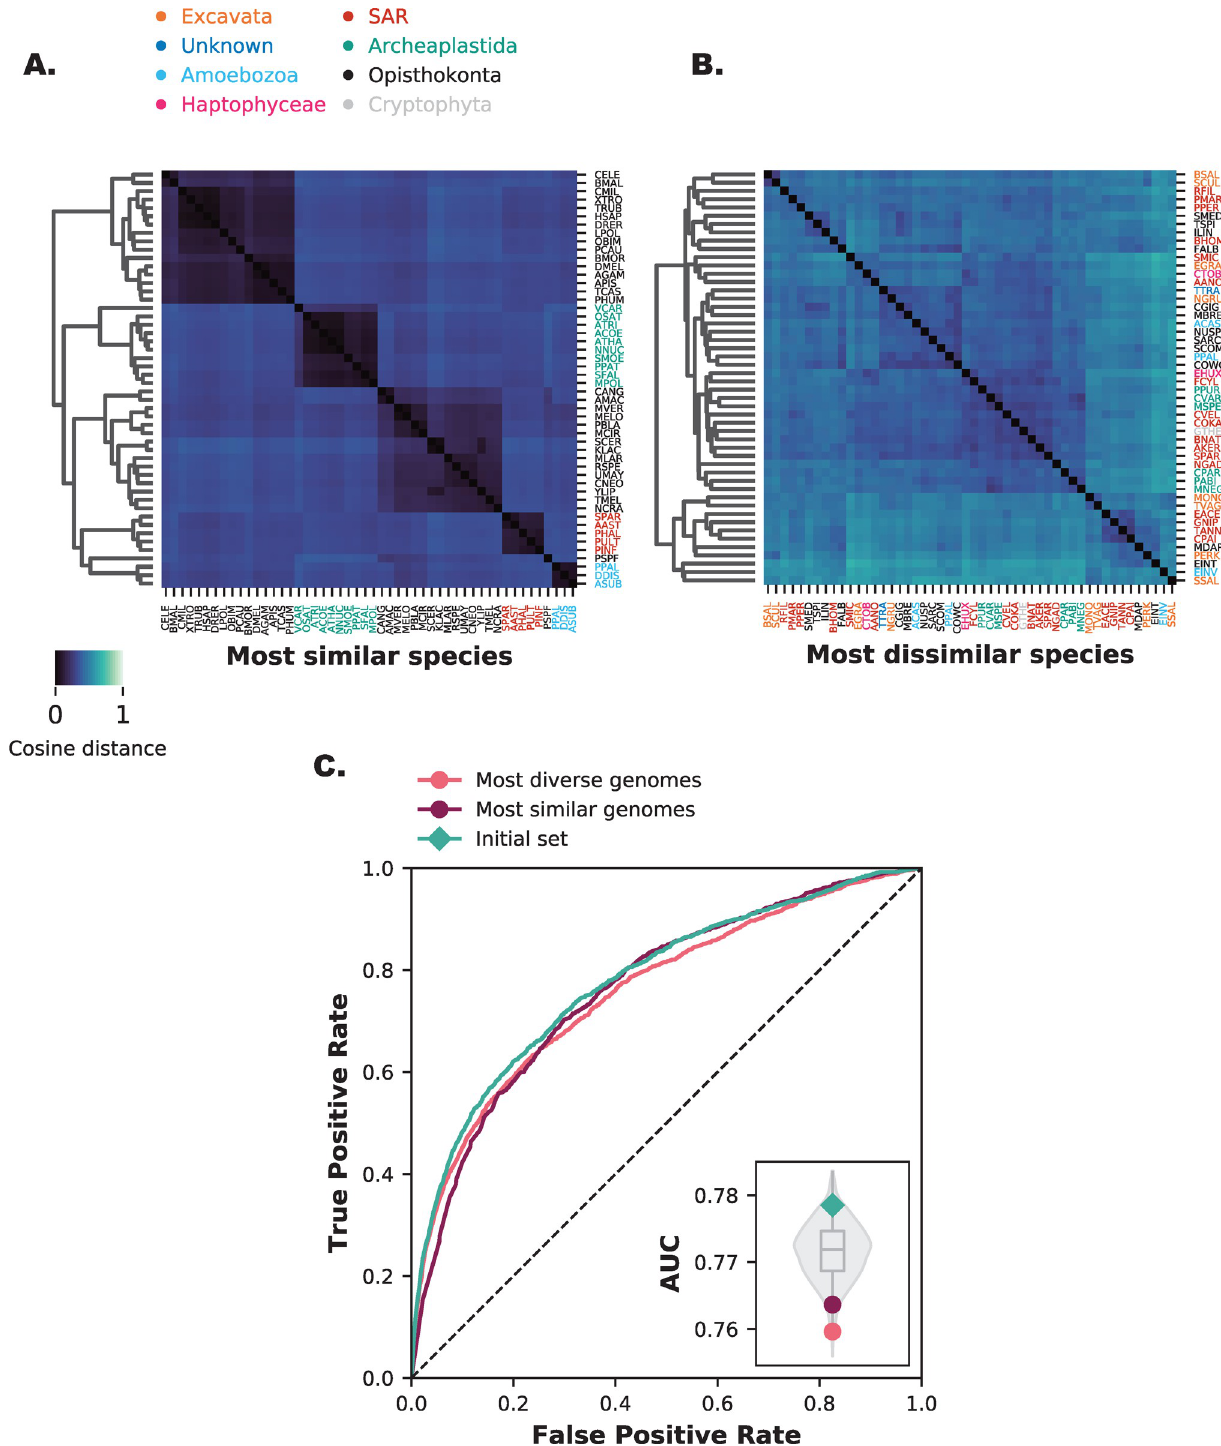
Fig 3. Both high and low diversity sets have little impact on protein interaction prediction performance. A. The most similar species form more clusters and are overall more similar to each other. B. The most diverse species show no clustering and are overall less similar to each other. C. Receiver- operator Curve of two species sets (n = 50) with the most diverse and most similar species. The inset gives the Area Under the Curve (AUC) values compared with the random backdrop of 1000 random species sets (violin plot) and the initial species set (green diamond). S3 Fig shows the results for Broccoli